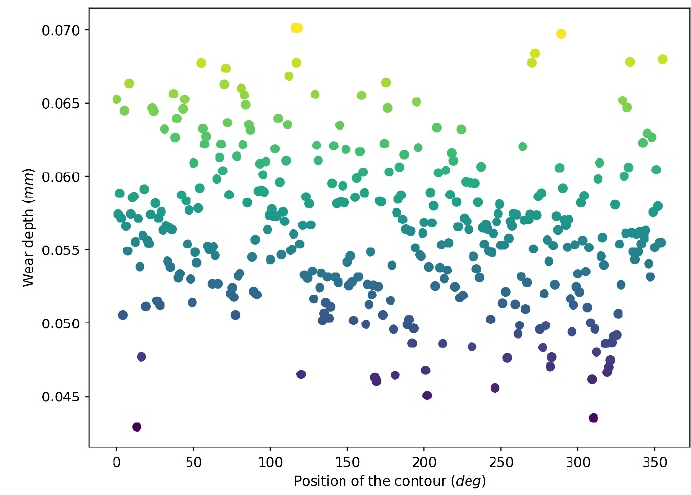
Figure 10. Wear depth distribution after 10 revolutions.